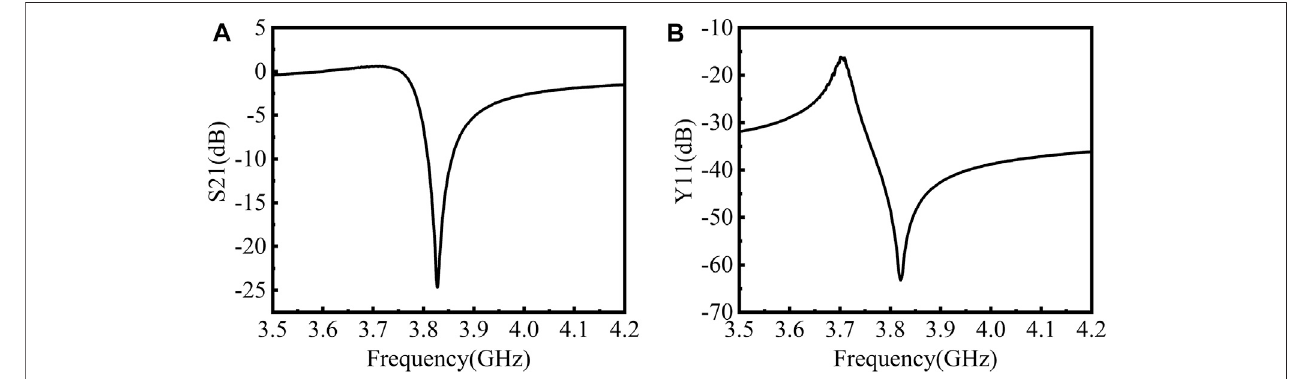
FIGURE 8 | Test results of the fabricated FBAR: (A) Transmission coef fi cient S21; (B) Input admittance Y11.